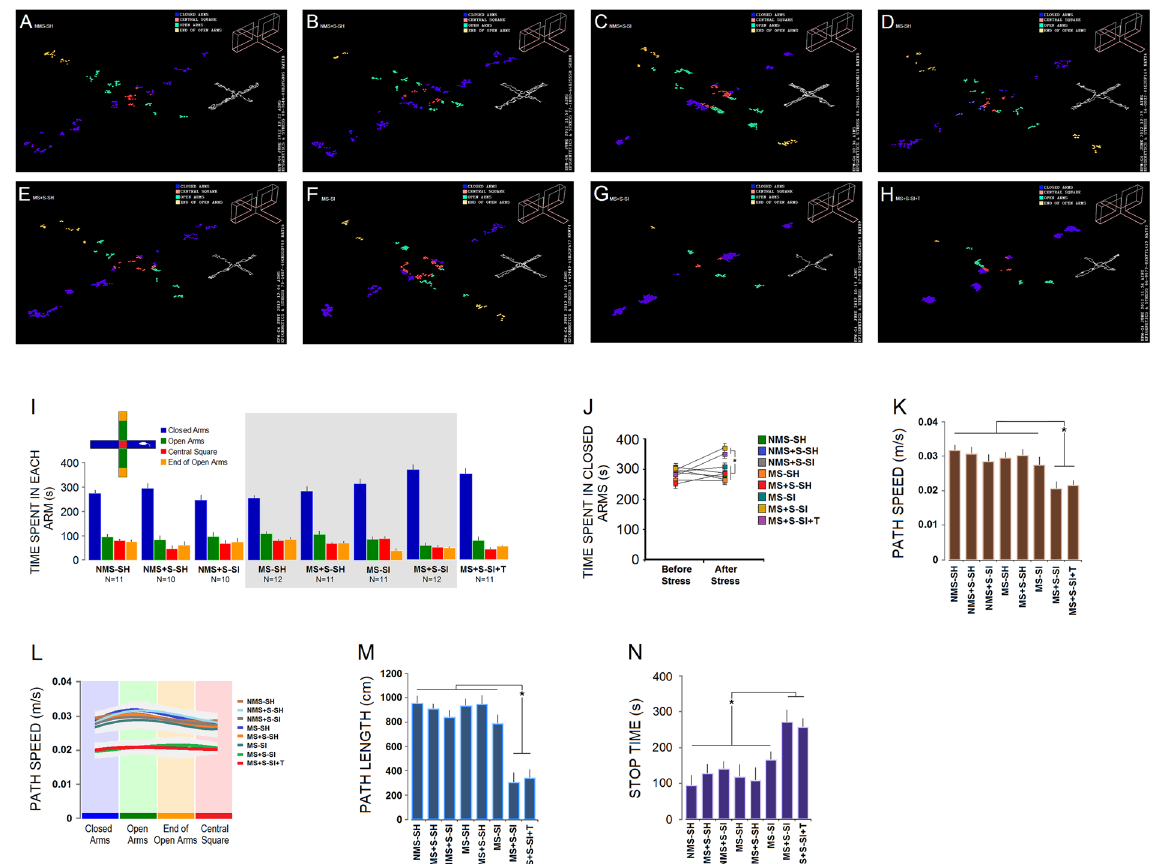
Figure 5. Combined ancestral and adulthood stress induce an anxiety-like state . ( A–H ) Dispersion of stops and paths made by rats in open and closed arms of the elevated plus maze shows different profiles of anxiety and motivation. ( G & H ) The MS + S-SI and MS + S-SI + T groups displayed higher anxiety and less motivation to explore the open arms than other groups. ( I & J ) MS + S-SI and MS + S-SI + T groups spent longer times in closed arms compared to other groups and compared to pre-stress session. They also explored the task with lower speed ( K & L ) associated with shorter path length ( M ) and more stop times ( N ) compared to other experimental groups. Asterisks indicate significant differences: * p ≤ 0.05; One-Way ANOVA. Error bars show ±